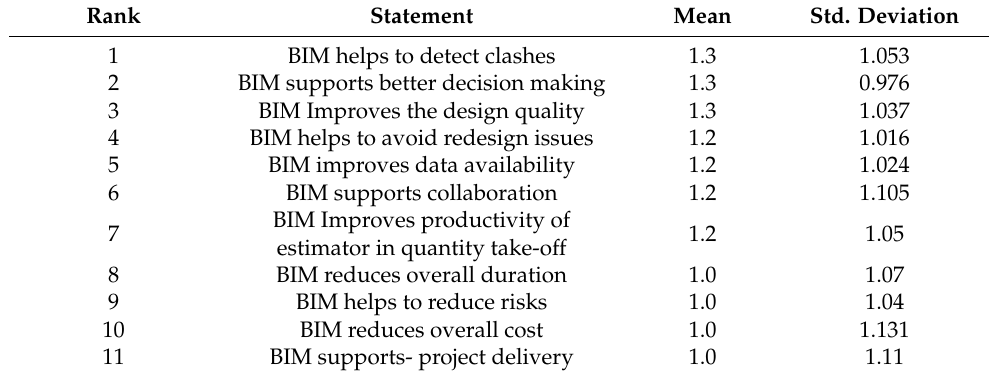
Table 1. Benefits of BIM.